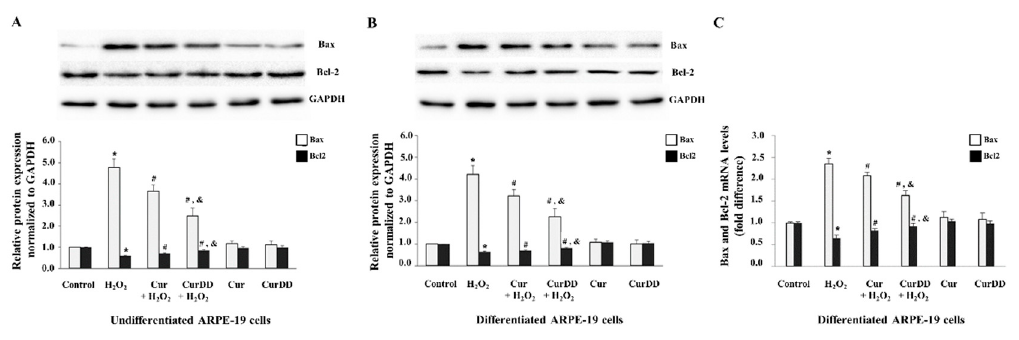
Figure 6. Protective effects of Cur and CurDD against oxidative stress occurs through modulation of apoptotic regulatory molecules Bax and Bcl-2. ARPE-19 cells were pre-treated with 10 µM of Cur or CurDD for 24 h, followed by H 2 O 2 treatment at appropriate concentrations (400 and 200 µM for undifferentiated and differentiate cells, respectively) for 6 h. Protein levels of Bax and Bcl2 were assessed by immunoblotting in ( A ) undifferentiated and ( B ) differentiated ARPE-19 cells. GAPDH immunodetection was used as a loading control. Representative Western blots shown, with graphs presenting average normalised protein expression; ( C ) mRNA levels of Bax and Bcl2 were analysed by qPCR. Graph represents average expression normalised against four housekeeping genes as described in Methods. (For both protein and mRNA, data is presented as mean ± SD values, n = 4; One-Way ANOVA test, * p ≤ 0.05 vs. control group, # p ≤ 0.05 vs. H 2 O 2 group, and & p ≤ 0.05 vs. Cur + H 2 O 2 group).